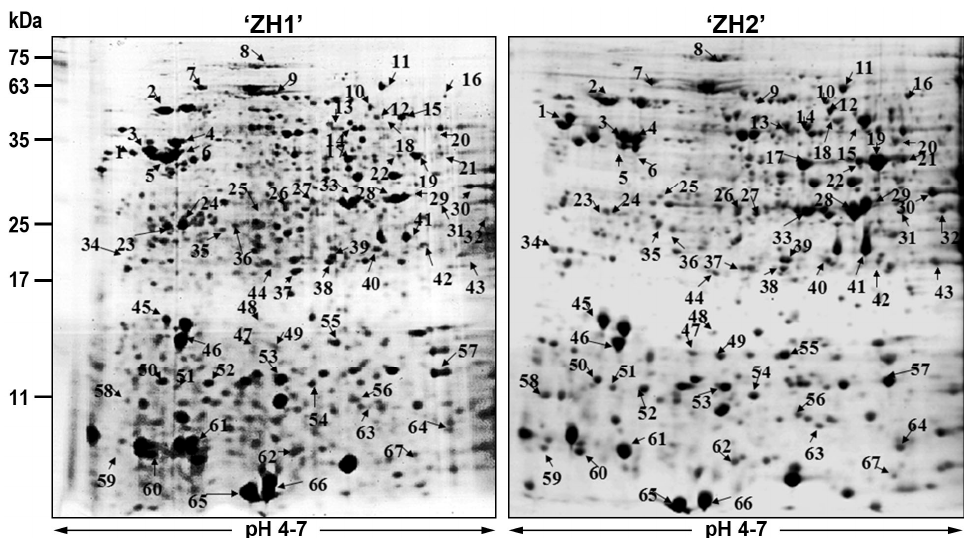
Figure 2. Two-dimensional gel electrophoresis (2-DE) image analysis of triploid ‘ZH1’ and diploid ‘ZH2’ P. deltoides . The numbers with arrows indicate the differentially expressed protein spots (DEPs) with p < 0.05.